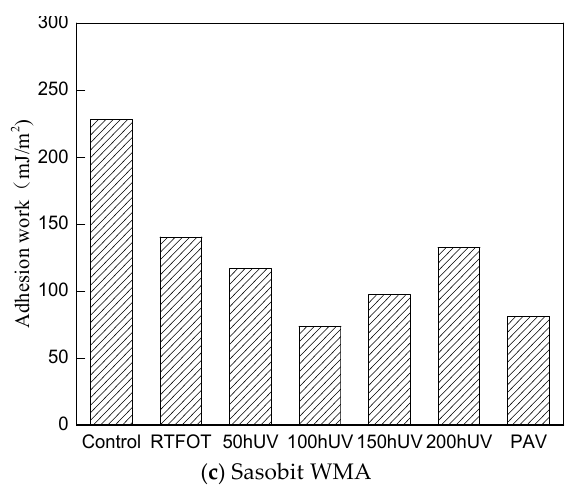
Figure 6. Influence of aging on adhesion work of aged asphalt.